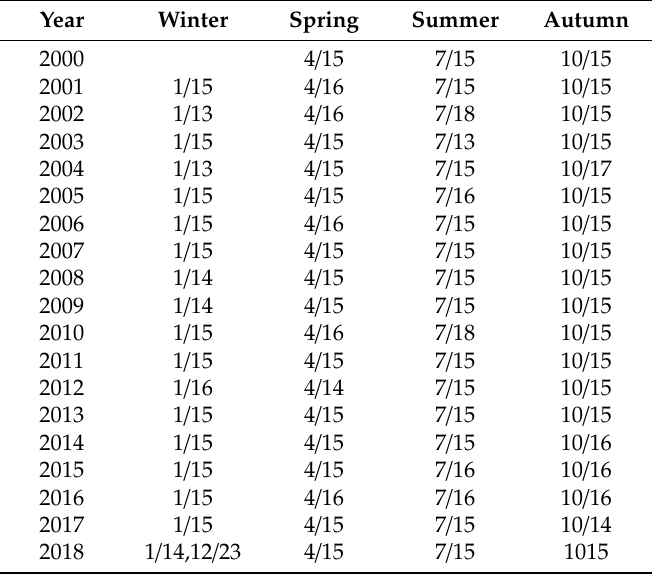
Table 2. Selected dates of training and testing samples in